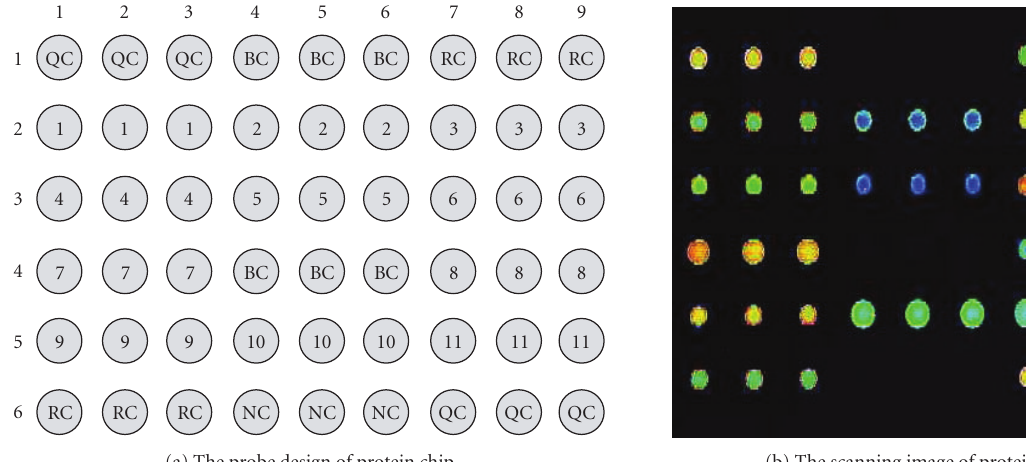
Figure 9: The application of protein chip for autoantibodies in patients